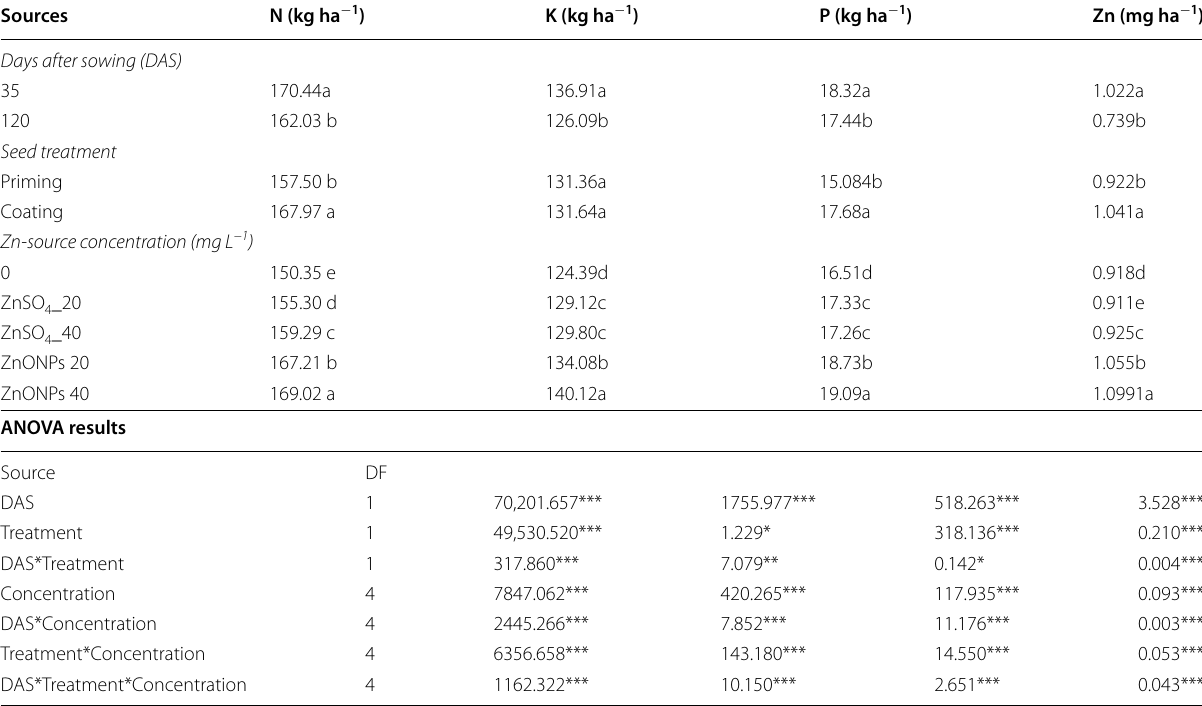
Table 4 Mean effect of DAS, seed treatments, and concentration of Zn‑source on soil nutrient content in maize crop (variety PMH‑1) grown under field